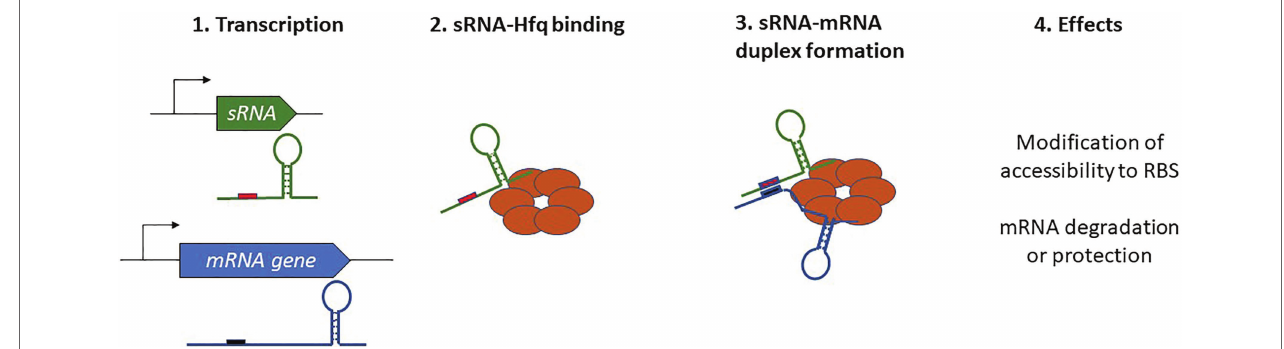
FIGURE 1 | Schematic overview of Hfq-dependent small regulatory RNA (sRNA) complex formation and the resulting effects on target